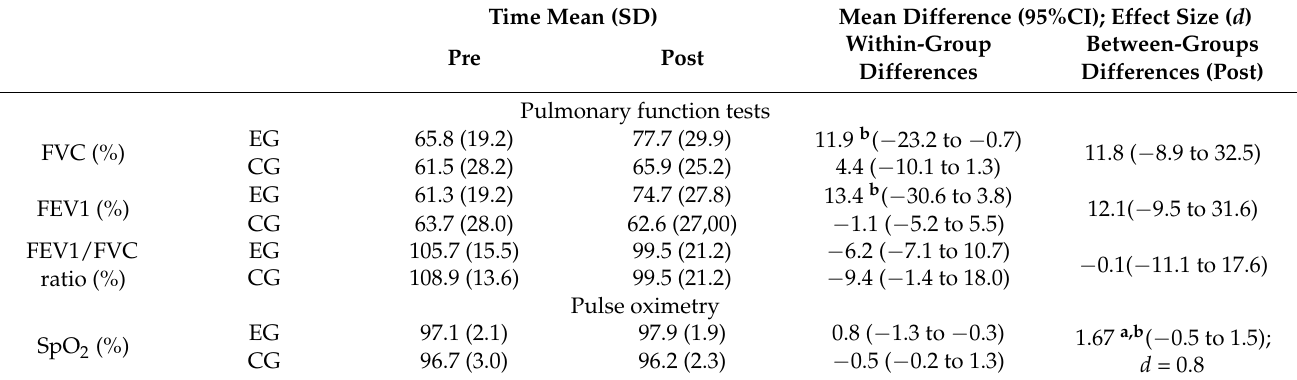
Table 3. Effect of the treatment on respiratory parameters in the experimental and control group.